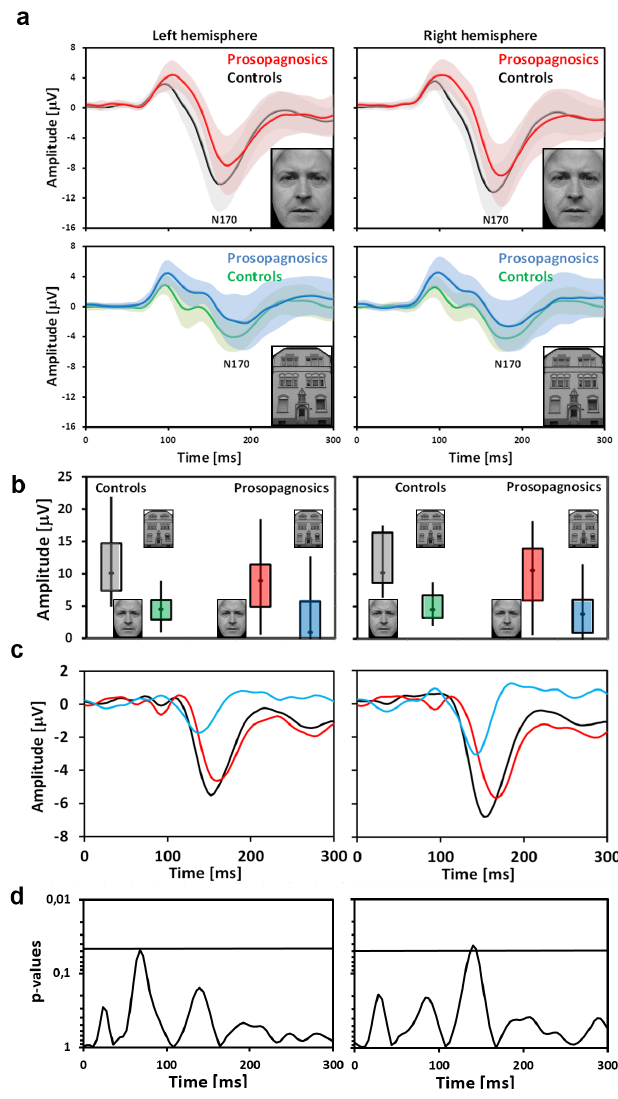
houses) by box plots. (C) Categorical difference curves: faces minus houses (red: persons with cPA, black: controls, blue: categorical difference cPA minus categorical difference controls “ double difference ” ). (D) Temporal evolution of interaction term (stimulus with group). The peak coincides with the peak of the “ double – difference curve ” (right